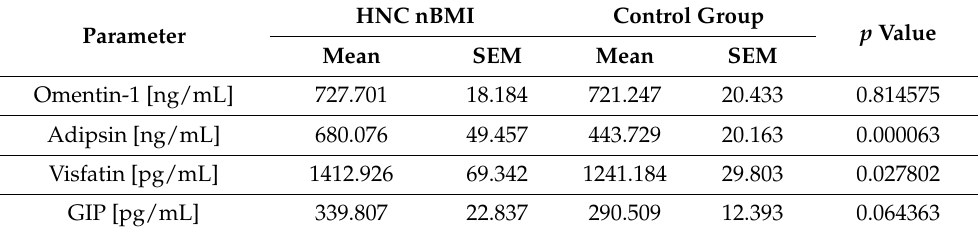
Table 4. Biochemical parameters with a statistically normal distribution analyzed in head and neck